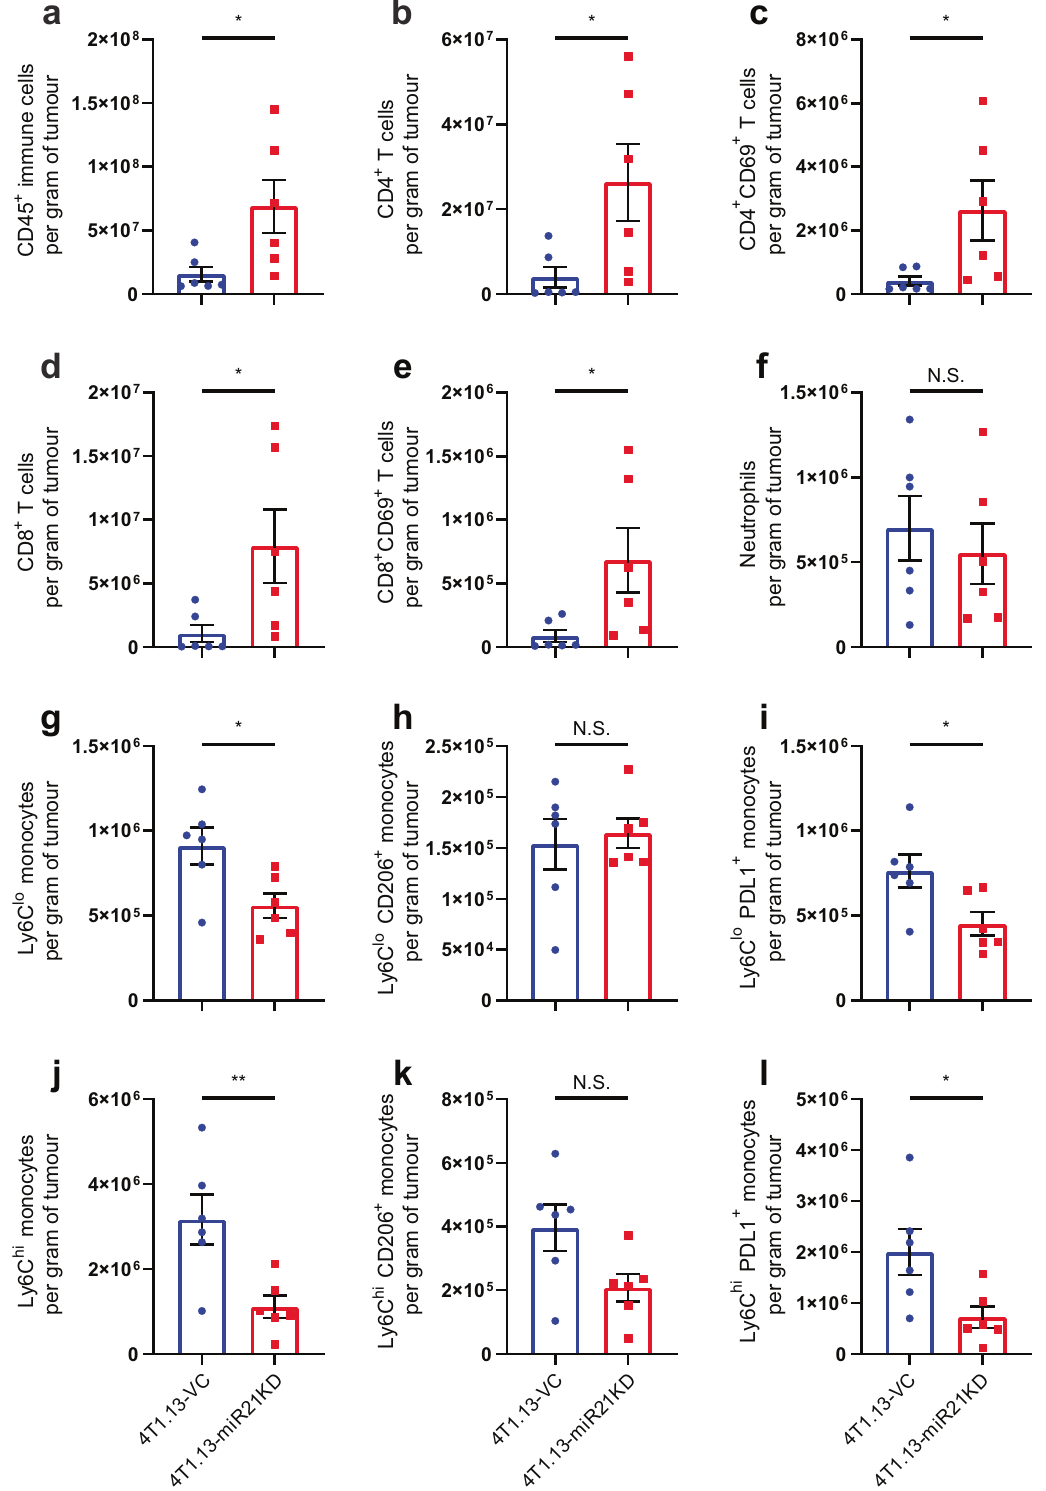
Fig. 4 Effect of miR-21 suppression on the immune pro fi le of 4T1.13 primary tumours. BALB/c mice bearing 4T1.13-VC (blue) or 4T1.13- miR-21-KD (red) mammary tumours (inoculum of 2 × 10 5 cells) were culled on day 12 and the tumours collected for fl ow cytometry analysis of in fi ltrating immune cell lineages. For each immune cell pro fi le, the mean ± SEM of 6 tumours is shown. The gating strategy is presented in Supplementary Fig. 3. a total CD45 + cells. b CD4 + T cells. c CD4 + CD69 + T cells. d CD8 + T cells. e CD8 + CD69 + T cells. f CD11b + Ly6G + neutrophils. g CD11b + ly6c lo monocytes. h CD11b + ly6c lo CD206 + monocytes. i CD11b + ly6c lo PD-L1 + monocytes. j CD11b + ly6c hi monocytes. k CD11b + ly6c hi CD206 + monocytes. l CD11b + ly6c hi PD-L1 +